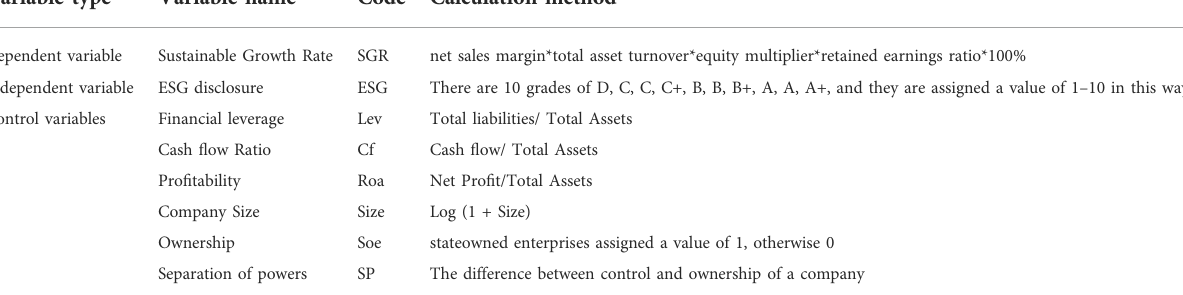
TABLE 1 Variable de fi nition and